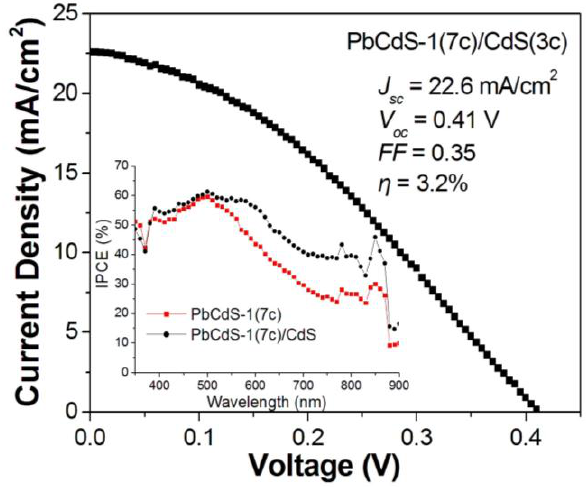
Figure 7. I–V curve of QDSC employing a hybrid QDs of PbCdS-1 (seven SILAR cycles) and CdS (three SILAR cycles), where PbCdS-1 was sensitized onto a TiO 2 film, followed by subsequently depositing CdS onto PbCdS-1. Inset: IPCE spectrum of the hybrid QDs compared to the corresponding PbCdS-1 QDs.